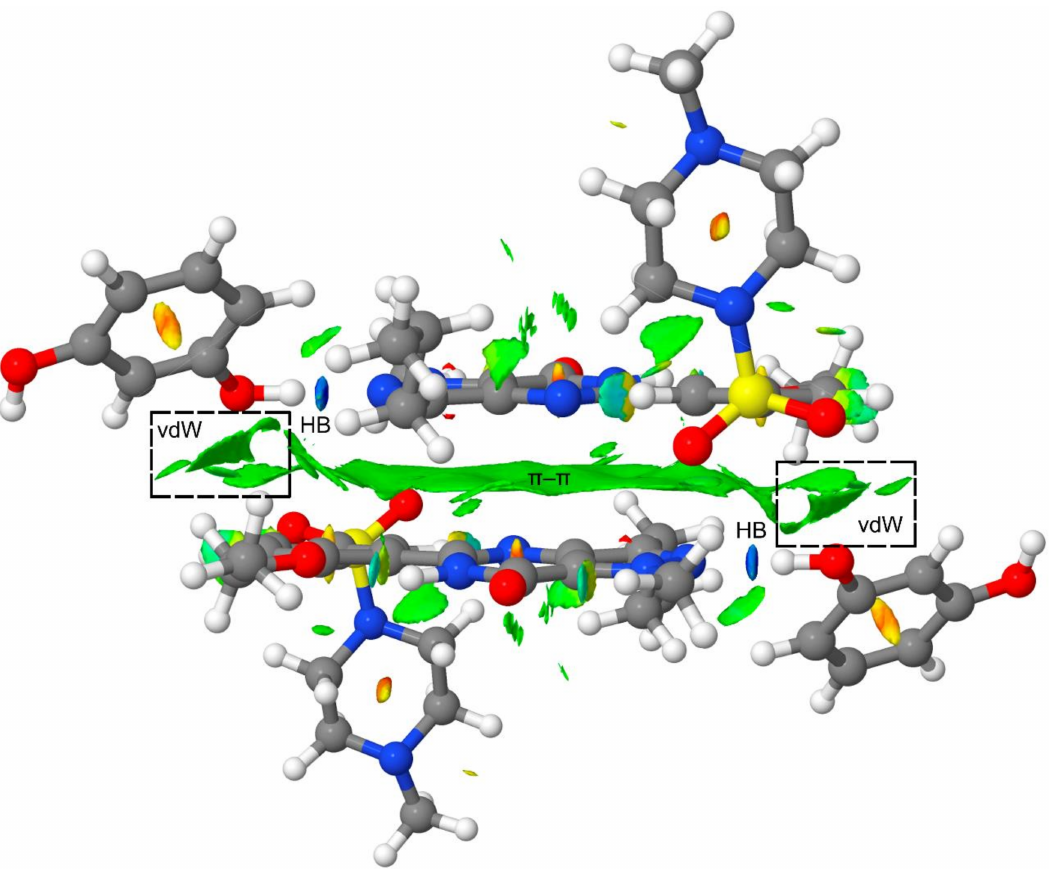
Figure 8. NCI plot of the tetrameric assembly at the PBE0-D3 / def2-TZVP level of theory. Range: − 0.04 < sign( λ ρ < 0.05 and RDG isosurface = 0.5 a.u. 2 )